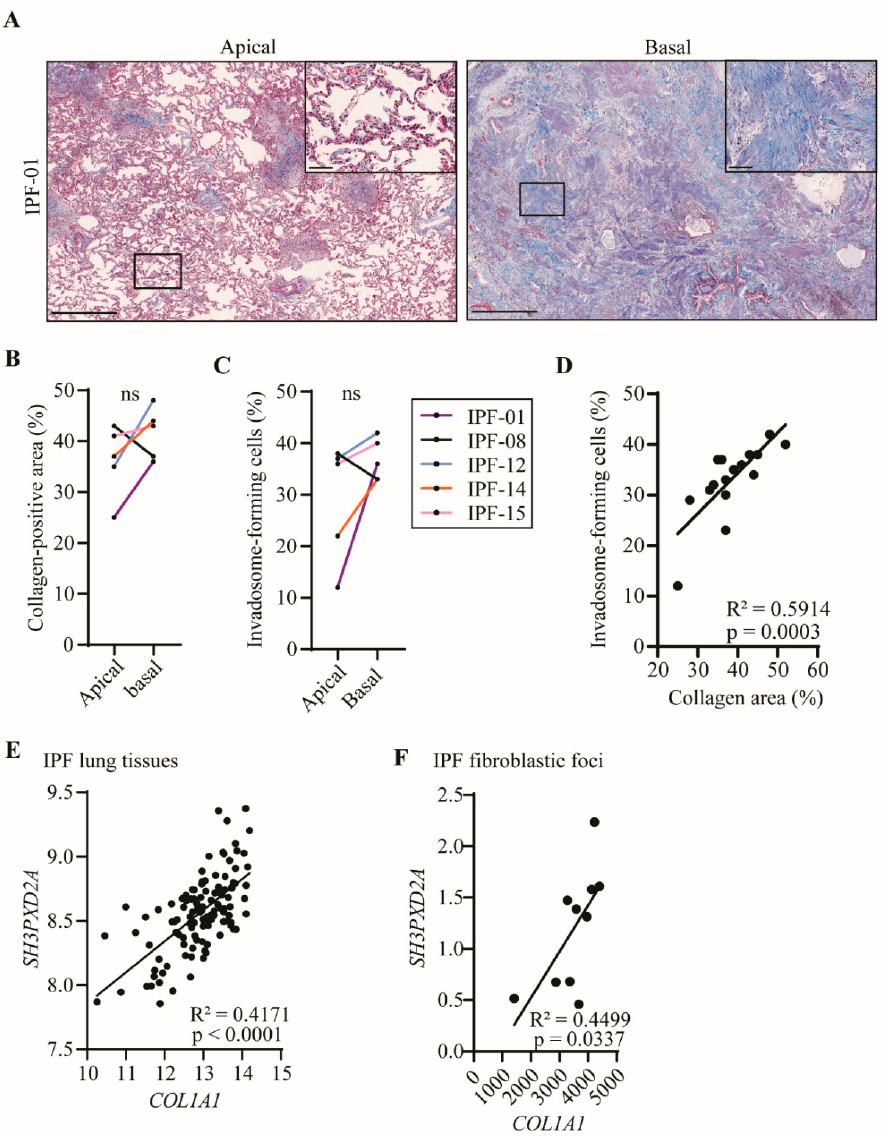
Figure 3. Invadosomes are found where collagen is heavily produced. ( A ) Images of apical and basal lung tissue sections stained for collagen with Masson’s trichrome from the same IPF patient showing different levels of fibrosis maturity. Scale bar = 1000 µm or 100 µm (zoom). For five patients, apical and basal lung samples were collected and ( B ) percentage of collagen-positive area as well as ( C ) percentage of fibroblast-forming invadosomes were determined. ( D ) Percentage of collagen-positive areas in lung tissues versus percentage of invadosome formation ( n = 17). TKS5 ( SH3PXD2A ) relative gene expression was correlated with COL1A1 expression in ( E ) IPF lung tissue ( n = 119) and in (F) IPF fibroblastic foci ( n = 10) using GSE32537 and GSE169500 cohorts, respectively. Given that nintedanib and pirfenidone, the two first-line IPF treatments, were shown to slow the rate of disease progression, it was of interest to investigate their effect on in- vadosome formation. Images of fibroblasts from an IPF patient illustrate the efficacy of